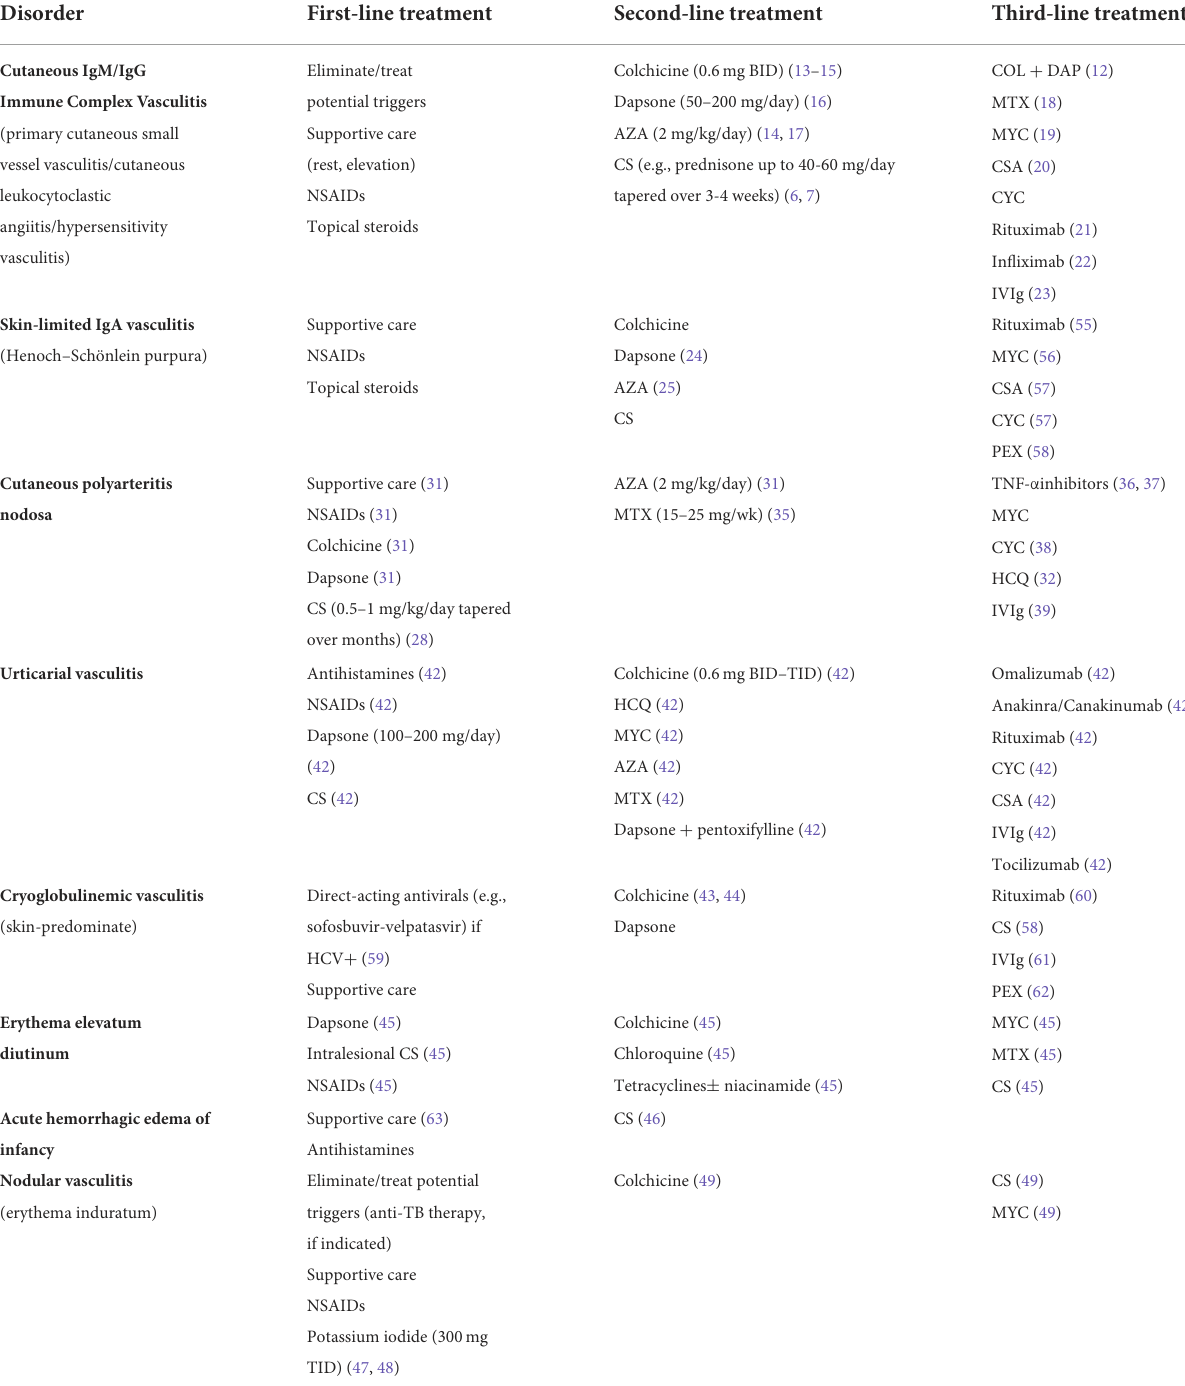
TABLE 1 Proposed therapeutic ladder for patients with various types of skin-limited